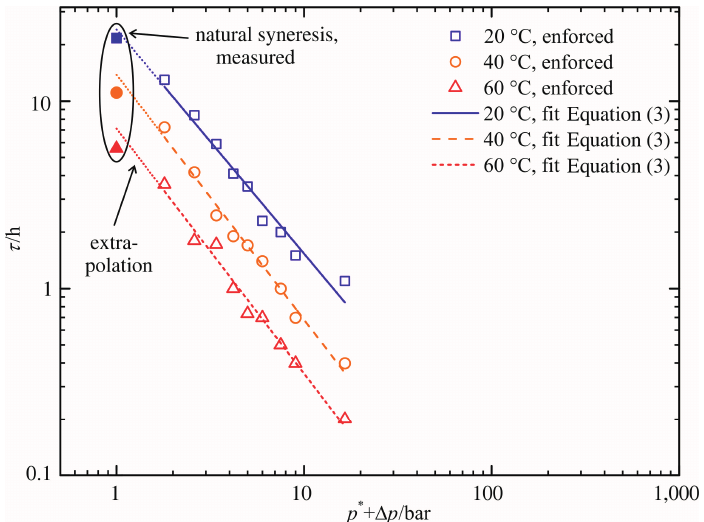
Figure 10. Characteristic time constant τ as a function of pressure difference Δ p